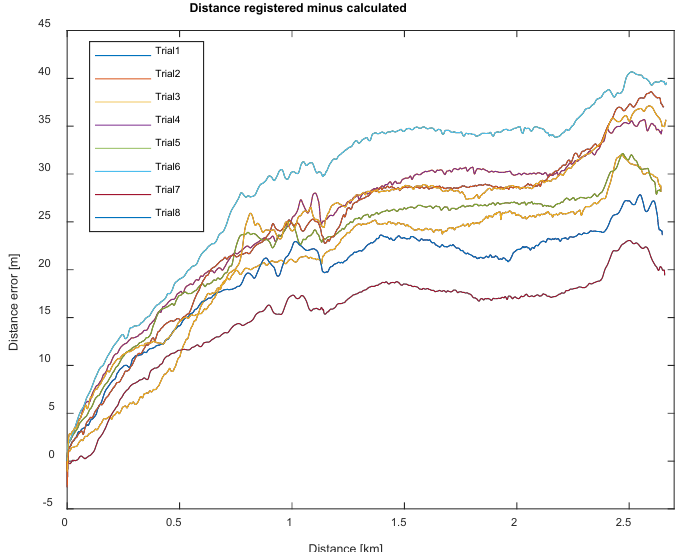
Figure 3. The difference between the recorded distance and the distance calculated from the speed signal.